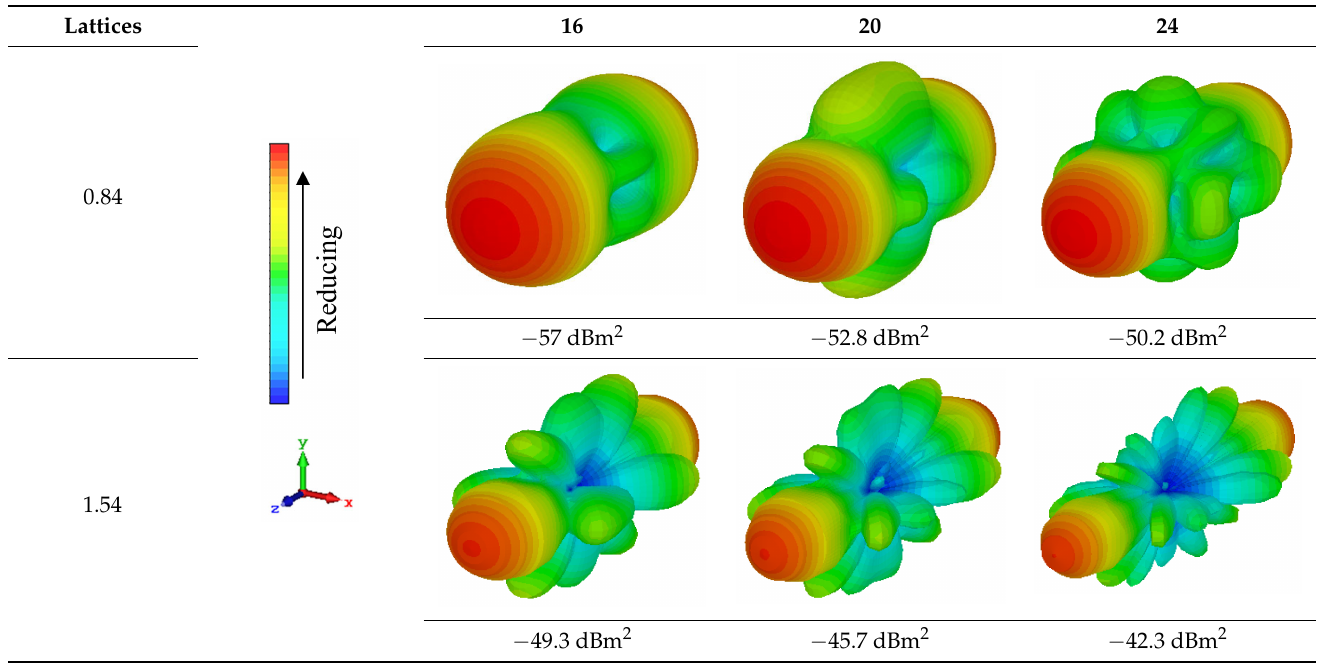
Figure 3. Monostatic RCS reduction of three different coding sequences in N = 16, N = 20, N = 24. Table 5. Bistatic RCS scattering patterns of three types of bigger lattices at 0.84 and 1.54